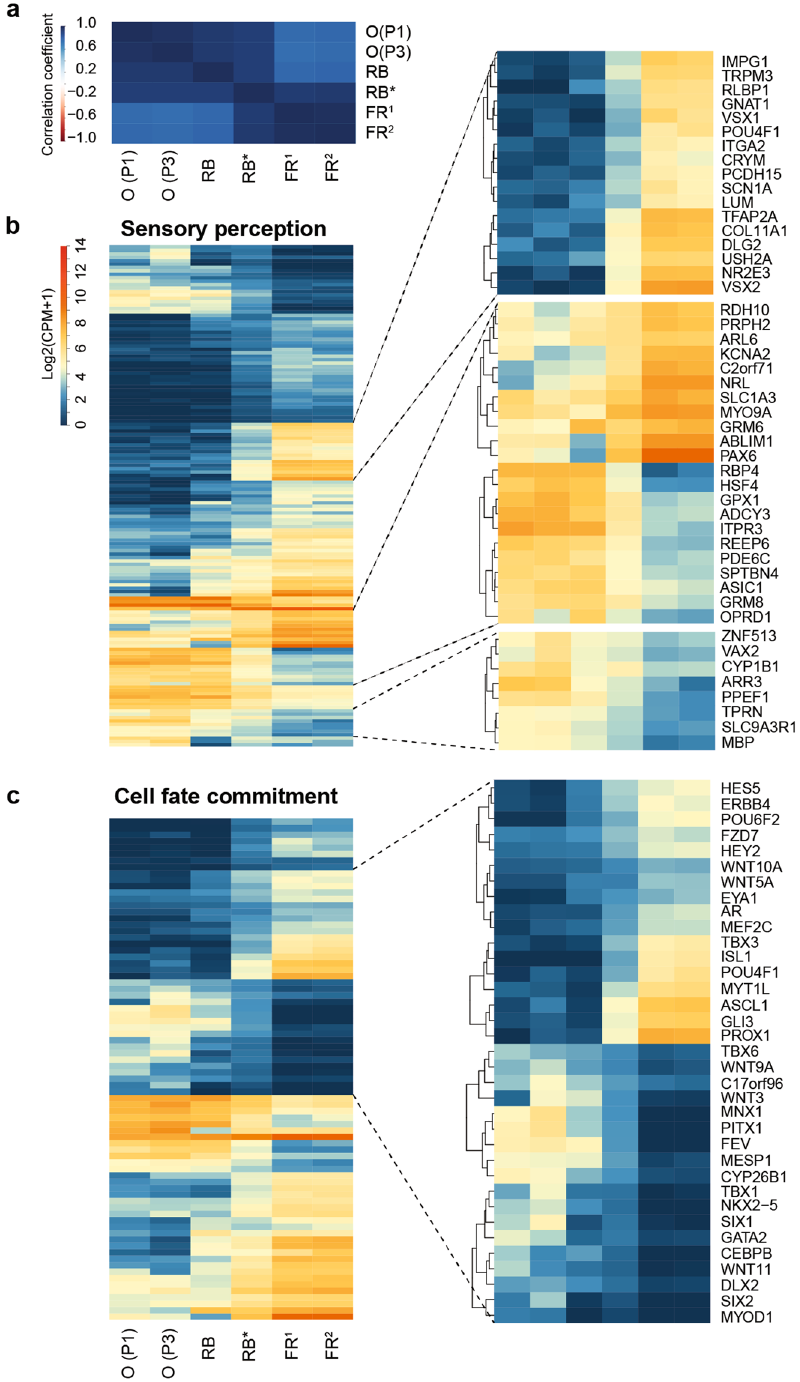
Figure 4. Tumor organoids recapitulate gene expression profile of primary retinoblastoma tissue. ( a ) Correlation matrix heat map between RB688 organoids (O) at passage 1 (P1, 6-week culture) and 3 (P3, 13-week culture), the corresponding patient-derived retinoblastoma (RB), and published transcriptomes of retinoblastoma (RB * ) and fetal retina (FR 1 and FR 2 ). ( b , c ) heat maps show expression levels of genes associated with the top two significantly enriched gene ontology (GO) terms: sensory perception ( b ) and cell fate commitment ( c ). See Fig. S5 for other GO terms and the expression levels of associated